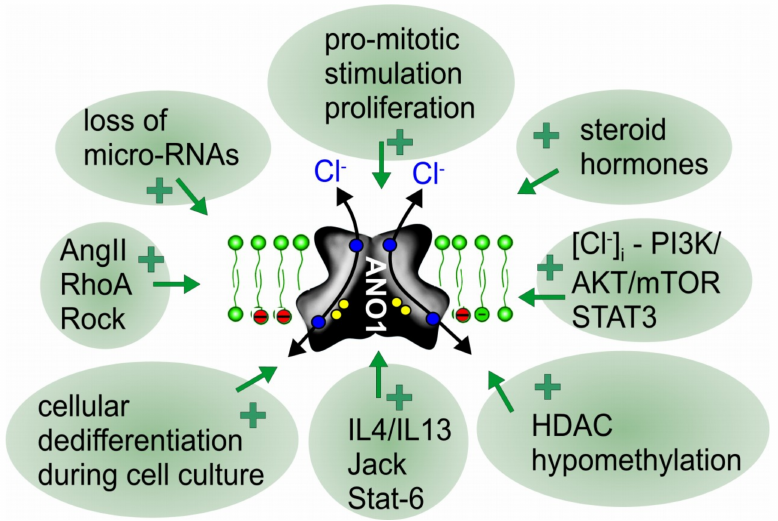
Figure 2. Upregulation and redistribution of ANO1 during proliferation and cancer. Scheme summarizing reported factors and signaling pathways that lead to upregulation of expression of ANO1 and cellular redistribution during proliferation and cancer growth (Table 1). For further details and references, see main